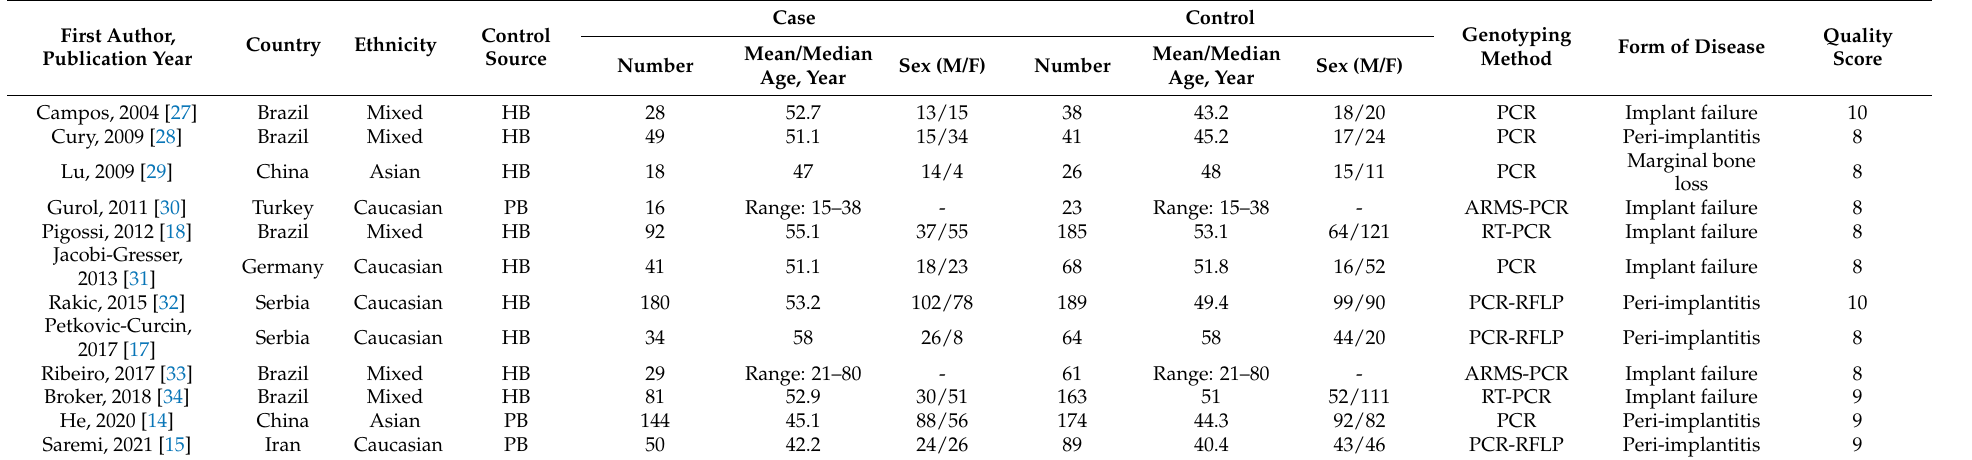
Table 1. Characteristics of studies included in the